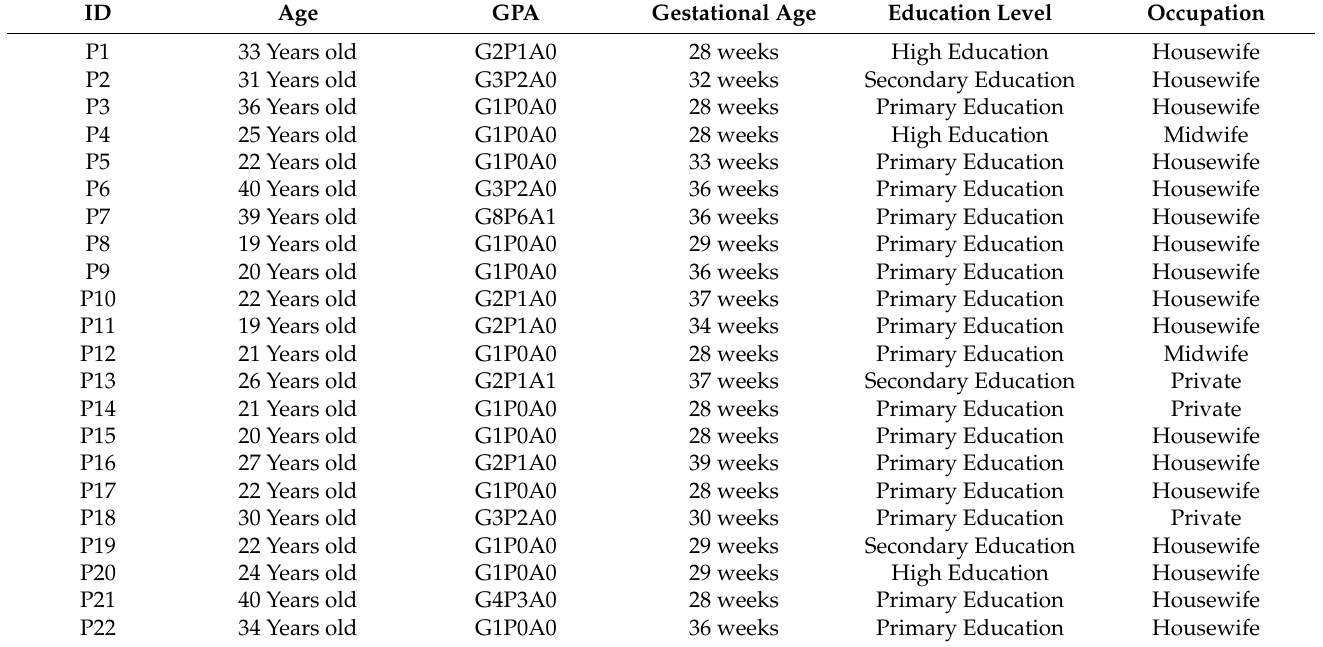
Table 1. Demography Characteristic (n =